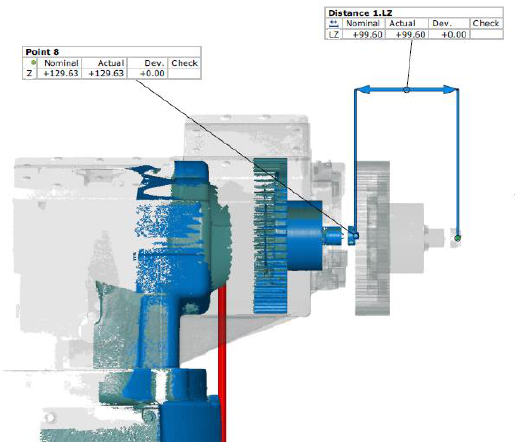
Fig. 15. Visualization of reference and modified cylinder head length comparison based on optical scan results